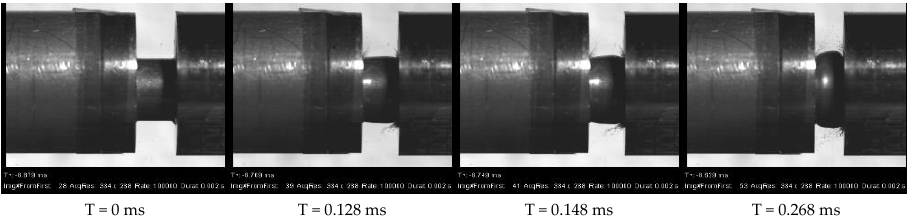
Fig 5. Images of the SHPB test carried out on a core-jacket sample at 11 m/s, 373 K, captured at different times.